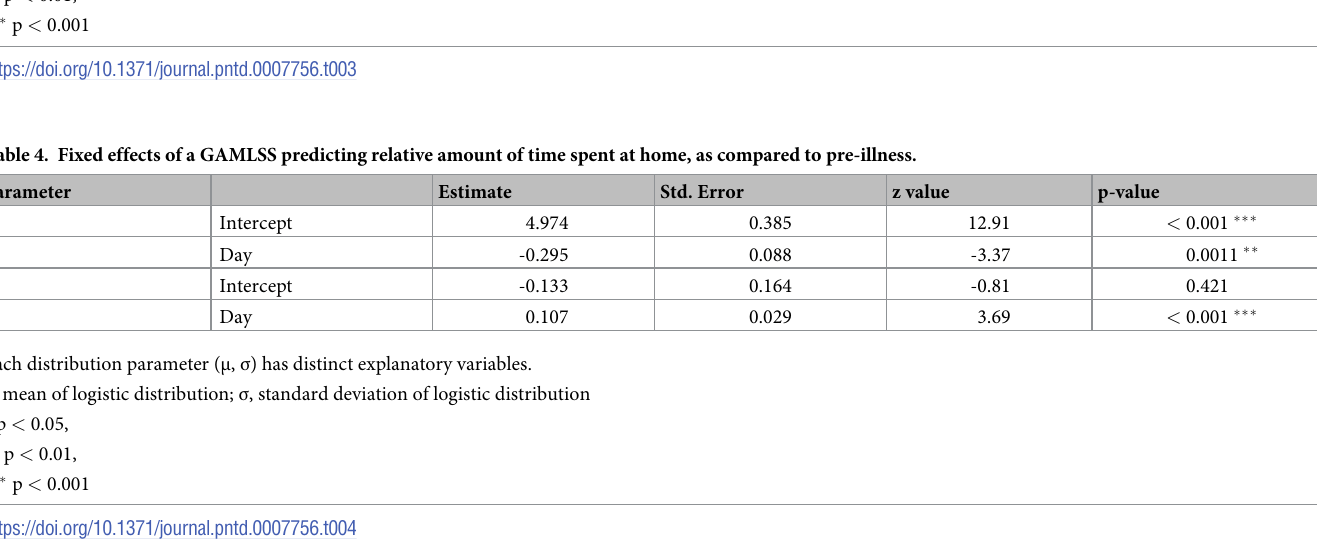
Table 3. Fixed effects of a GAMLSS predicting relative number of locations visited, as compared to pre-illness. Parameter